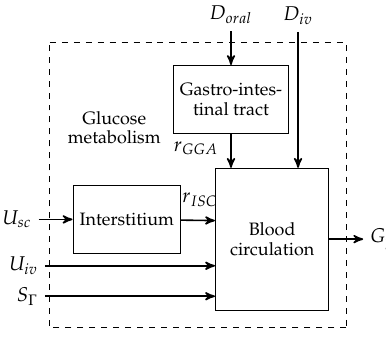
Figure 2. Göttingen Minipig model block